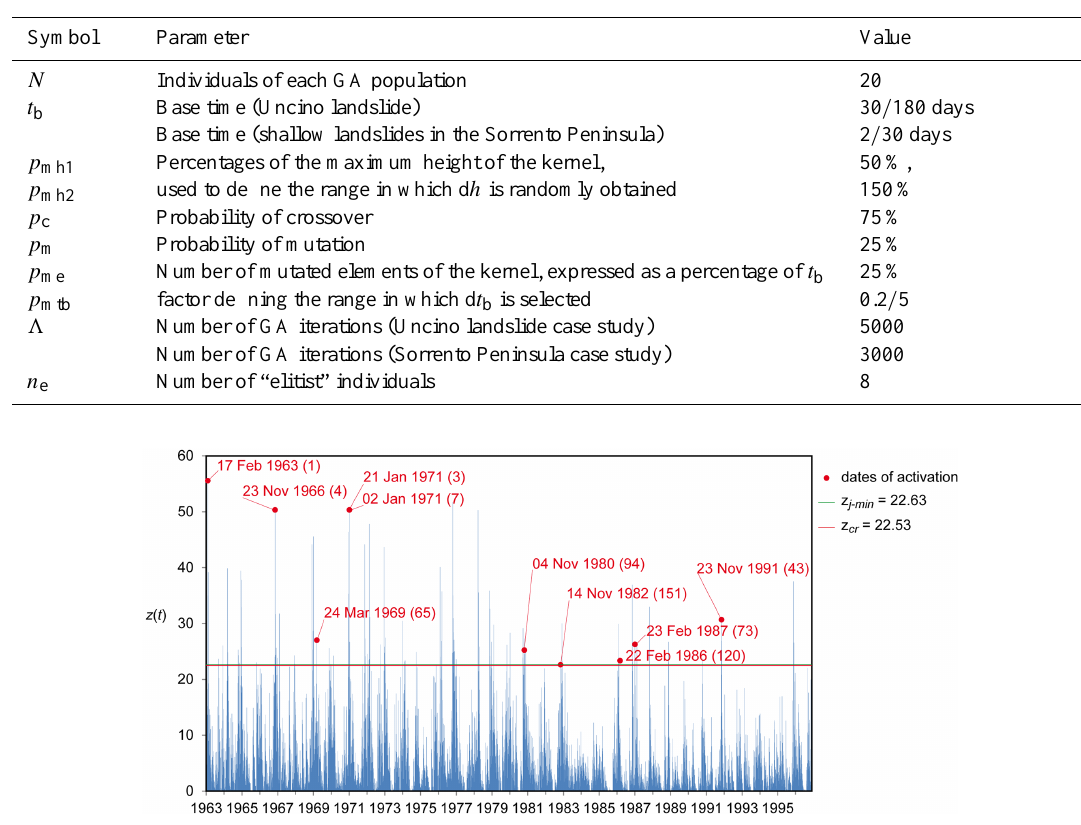
Table 4. Values of the parameters of GA SAKe adopted in the calibration procedure (benchmark experiment).